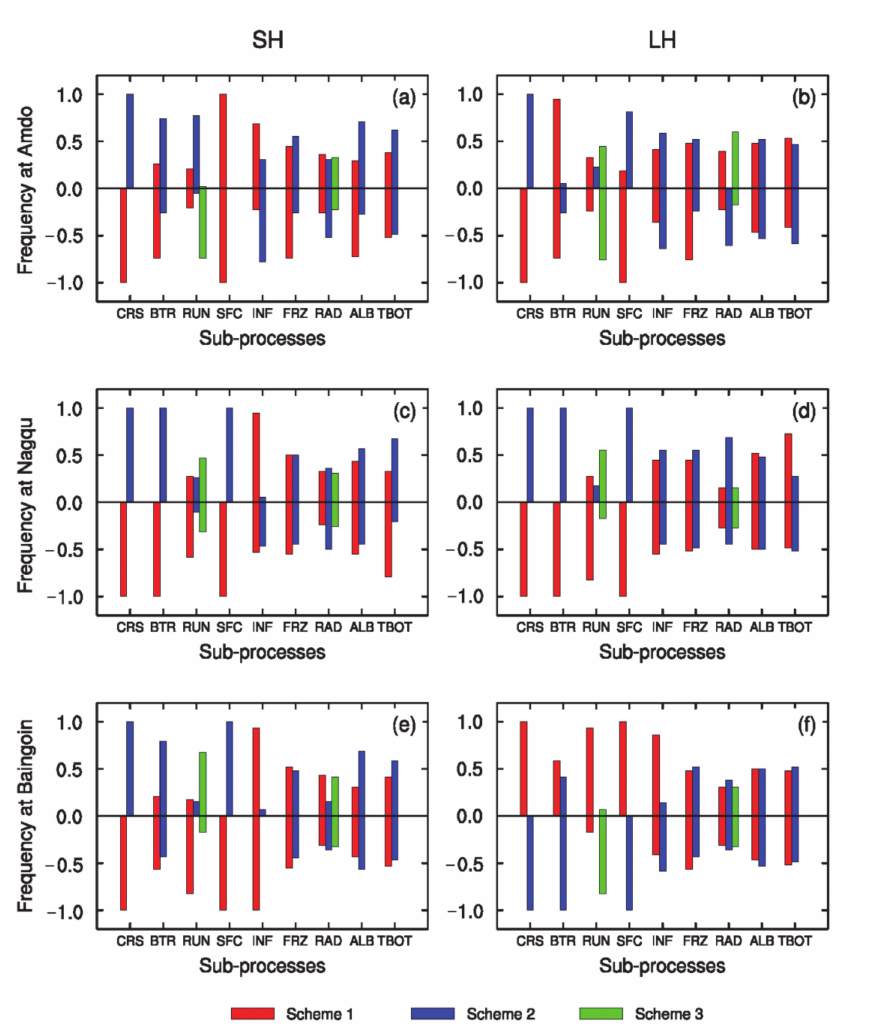
Figure 8. The selected frequency of di ff erent schemes of each subprocess for (left panel) SH and (right panel) LH in the best members (0–1) or worst members ( − 1–0) at the ( a , b ) Amdo, ( c , d )